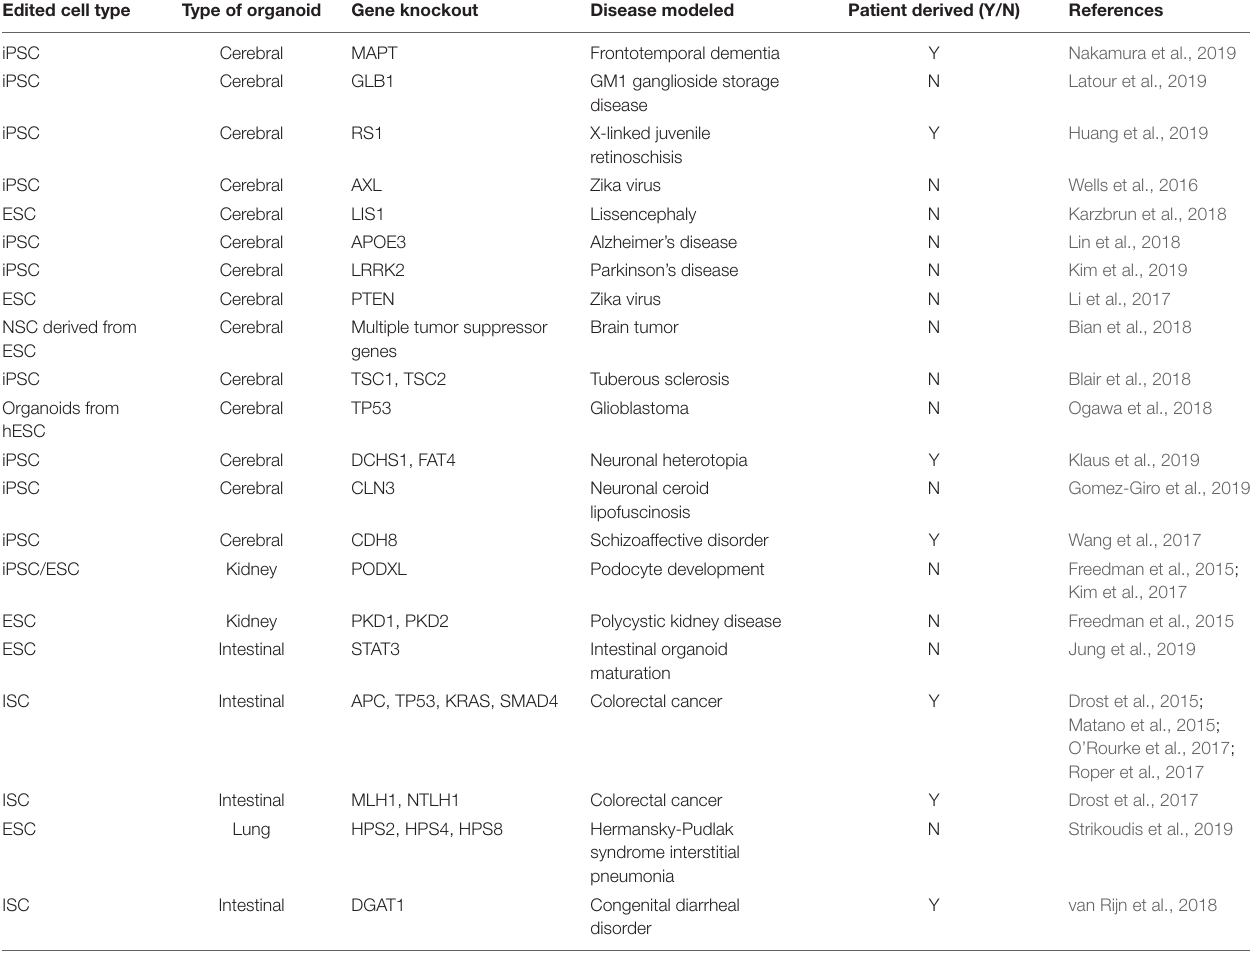
TABLE 1 | Examples of CRISPR Cas9 to introduce disease causing mutations.